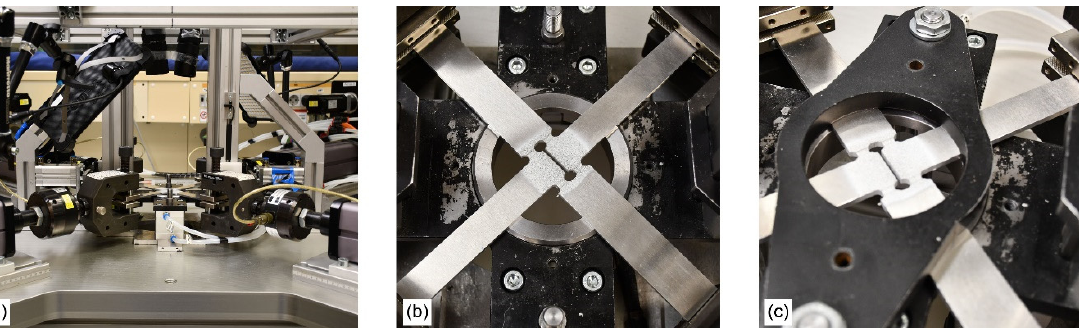
Figure 2. Experimental setup: ( a ) biaxial machine and DIC system; ( b ) down-holder and specimen in open position; and ( c ) closed position.